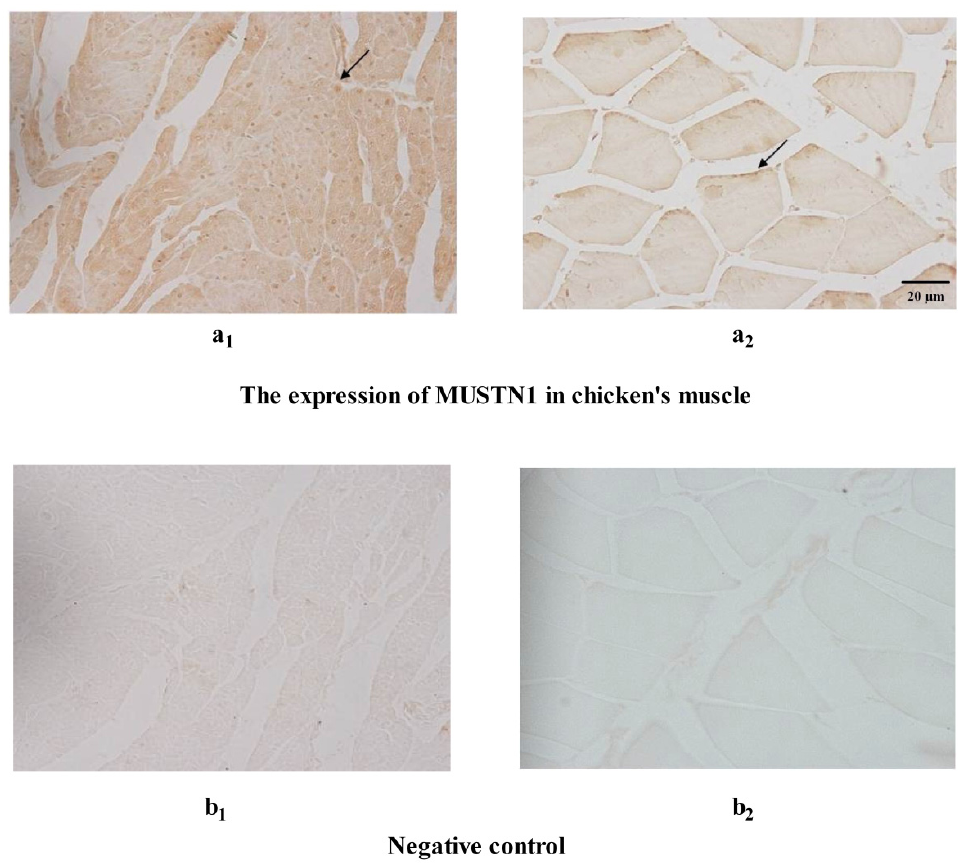
Figure 4. Immunohistochemical staining of MUSTN1 in chicken myocardium and skeletal muscle (pectoralis major) at day 70 post-hatch. Bars represent 20 μ m. ( a (×400), ( a ) transection of skeletal muscle (×400); Negative control: ( b 2 ) transection of skeletal muscle (×400); Negative control were stained by (×400), ( b 2 hematoxylin-eosin: ( c ) myocardium (×400), ( c ) transection of skeletal muscle 1 2